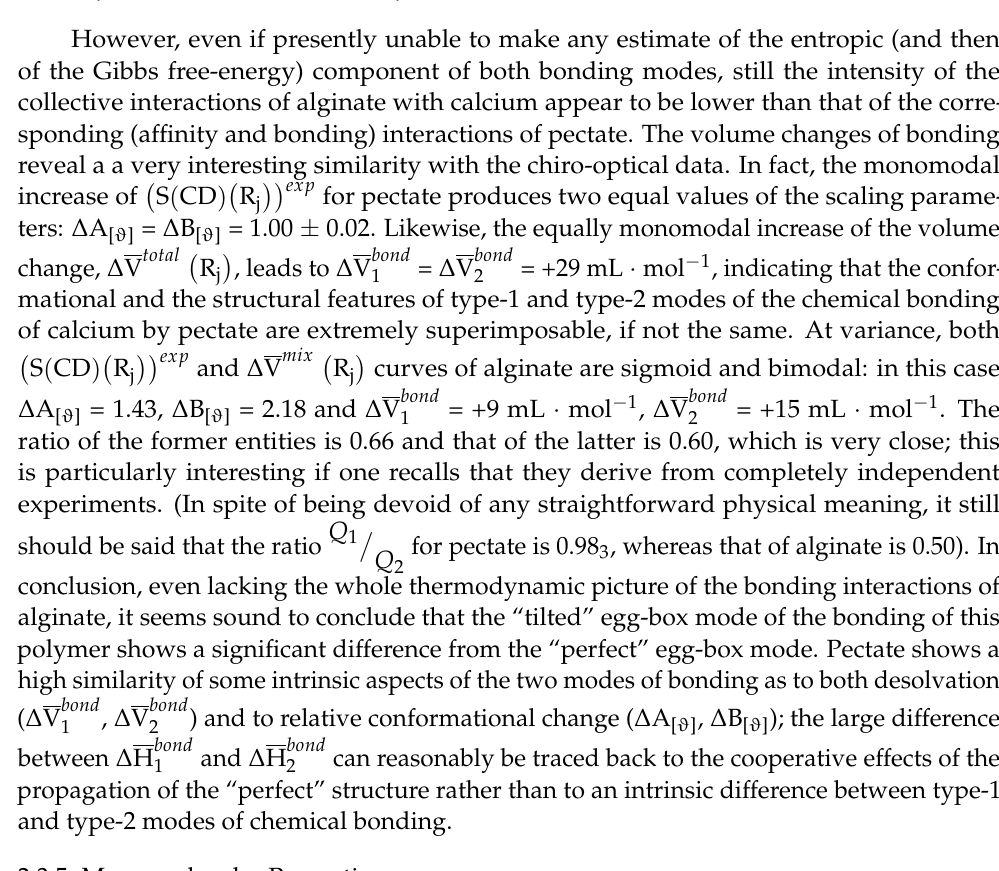
Figure 11. Enthalpy change of mixing calcium ions with L. hyp . alginate (red full circles) in aqueous 0.05 M NaClO 4 at 25.0 ◦ C, as a function of R j (full black squares). Data taken from ref. [24]. “aff” stands for ∆H(cid:3365) (cid:3028)(cid:3033)(cid:3033) ∙ 𝛲 (cid:3030)(cid:3042)(cid:3041)(cid:3031) (cid:3435)R (cid:2920) (cid:3439) , “el” for (cid:4672)1 − 𝜃(cid:3435)R (cid:2920) (cid:3439)(cid:4673) ∙ H (cid:3004)(cid:3032)(cid:3039) (cid:3435)R (cid:2920) (cid:3439) + 𝜃(cid:3435)R (cid:2920) (cid:3439) ∙ H (cid:3005)(cid:3032)(cid:3039) (cid:3435)R (cid:2920) (cid:3439) − H (cid:3004)(cid:3032)(cid:3039) (cid:3435)R (cid:2920) = 0(cid:3439) , “bond, 1” for 𝜃 (cid:2869) (cid:3435)R (cid:2920) (cid:3439) ∙ ∆H(cid:3365) (cid:2869) and “bond, 2” for 𝜃 (cid:2870) (cid:3435)R (cid:2920) (cid:3439) ∙ ∆H(cid:3365) (cid:2870) , respectively.